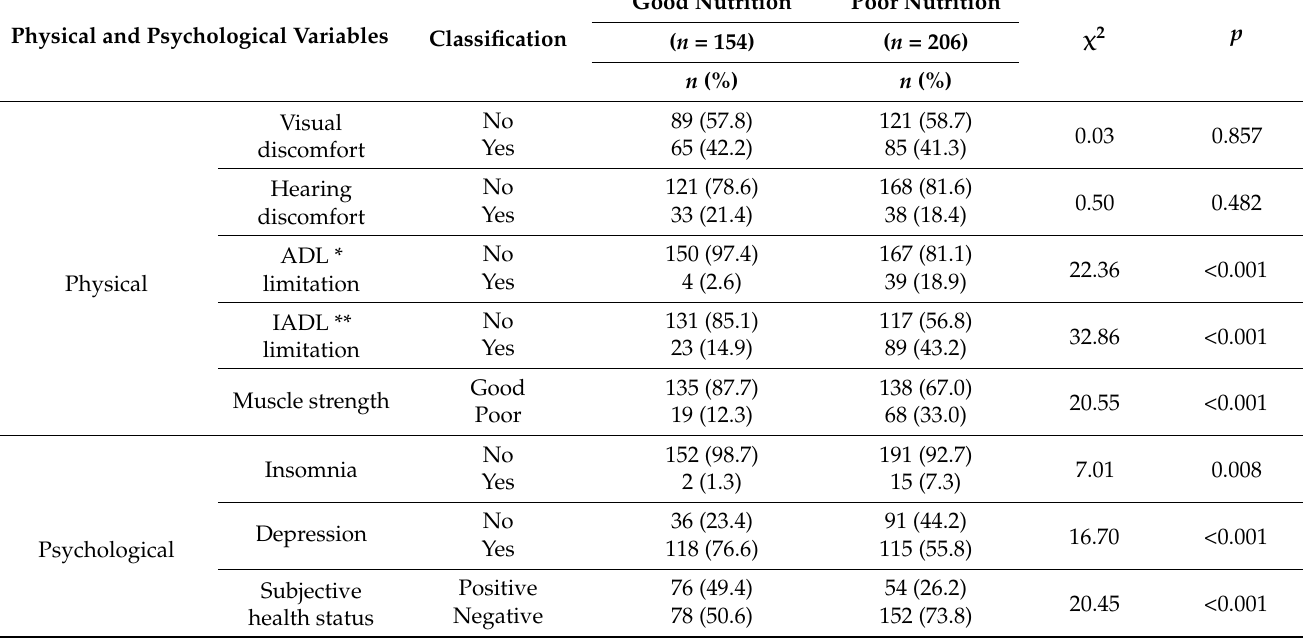
Table 2. Differences in physical and psychological characteristics between good and poor nutrition ( n = 360).